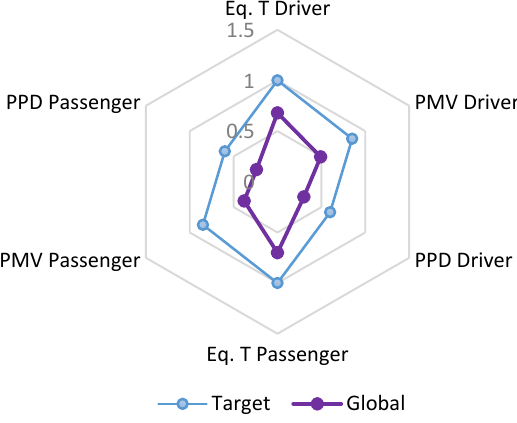
Figure 10. The general thermal comfort index (GTCI) using Fanger’s model.